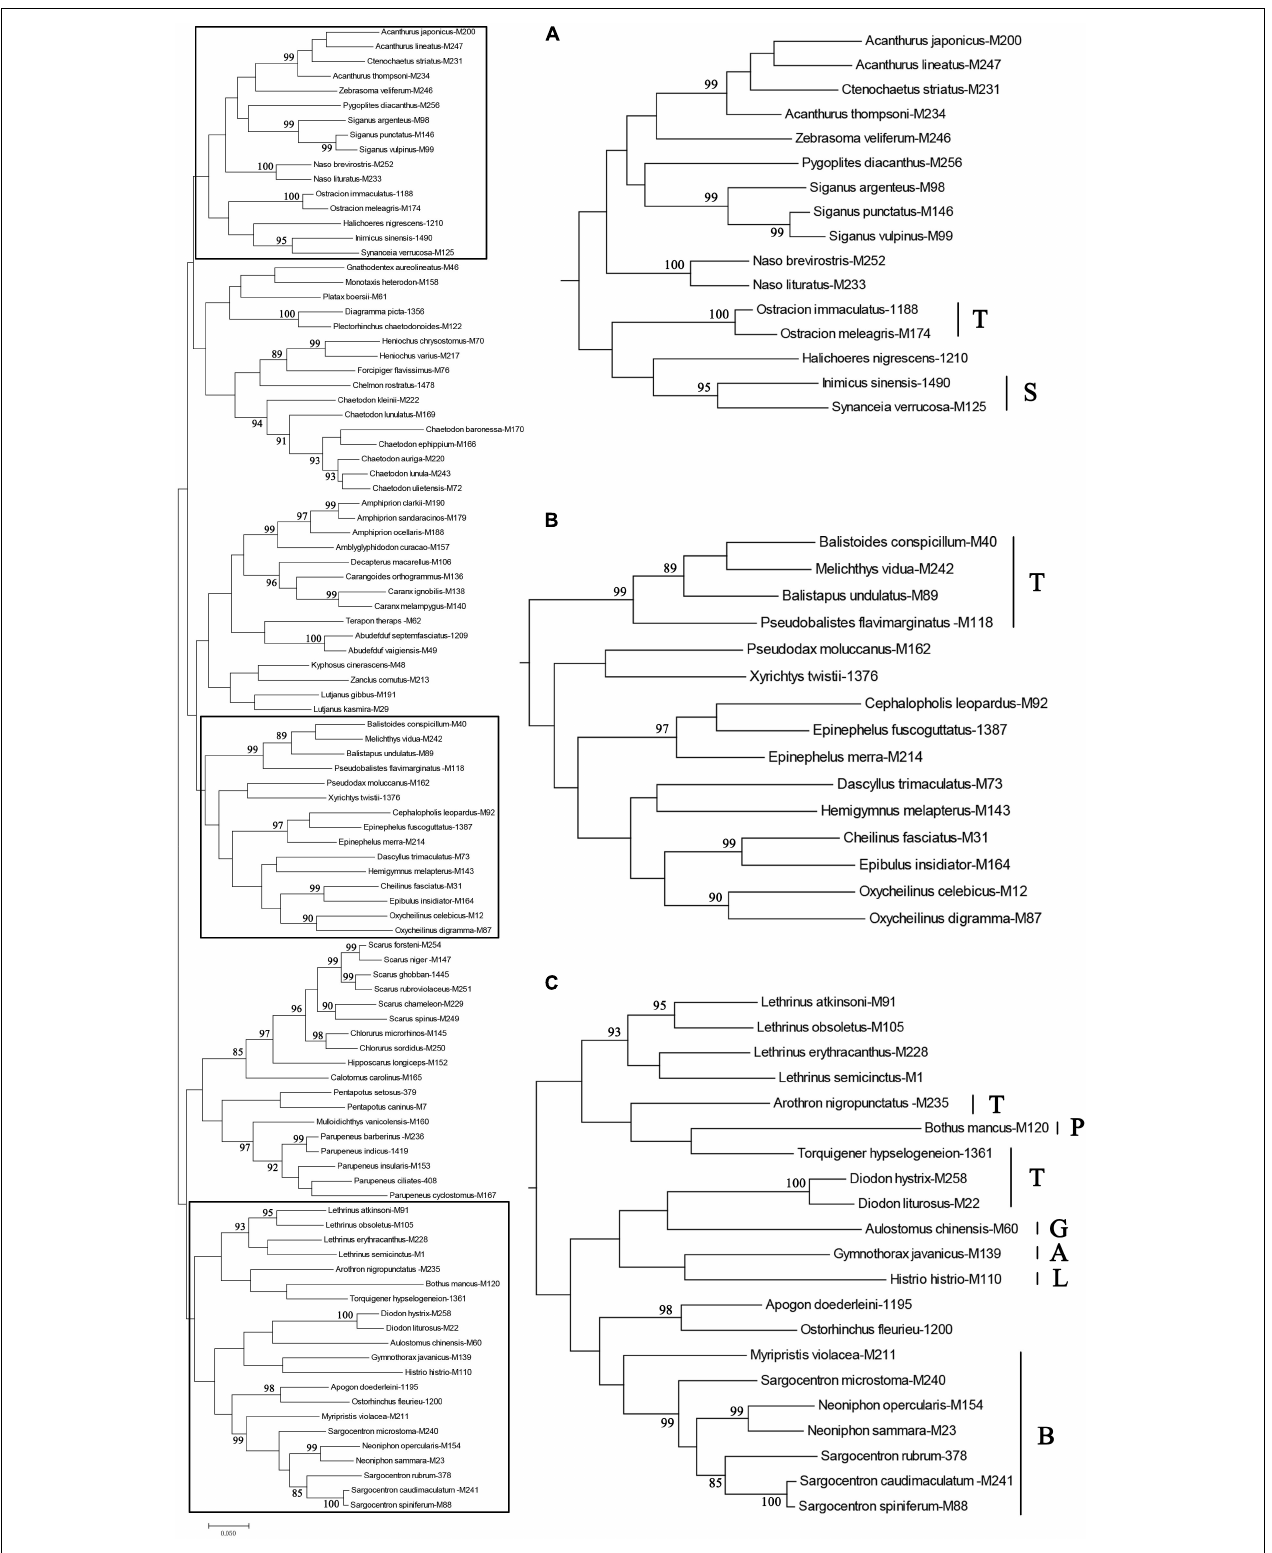
FIGURE 4 | Maximum likelihood tree based on COI barcodes obtained from 101 species: A, Anguilliformes; B, Beryciformes; G, Gasterosteiformes; L, Lophiiformes; P, Pleuronectiformes; S, Scorpaeniformes; T, Tetraodontiformes. Numbers on branches are ML bootstrap values, those below 85% are hidden; (A–C) are larger versions of parts of the Maximum likelihood